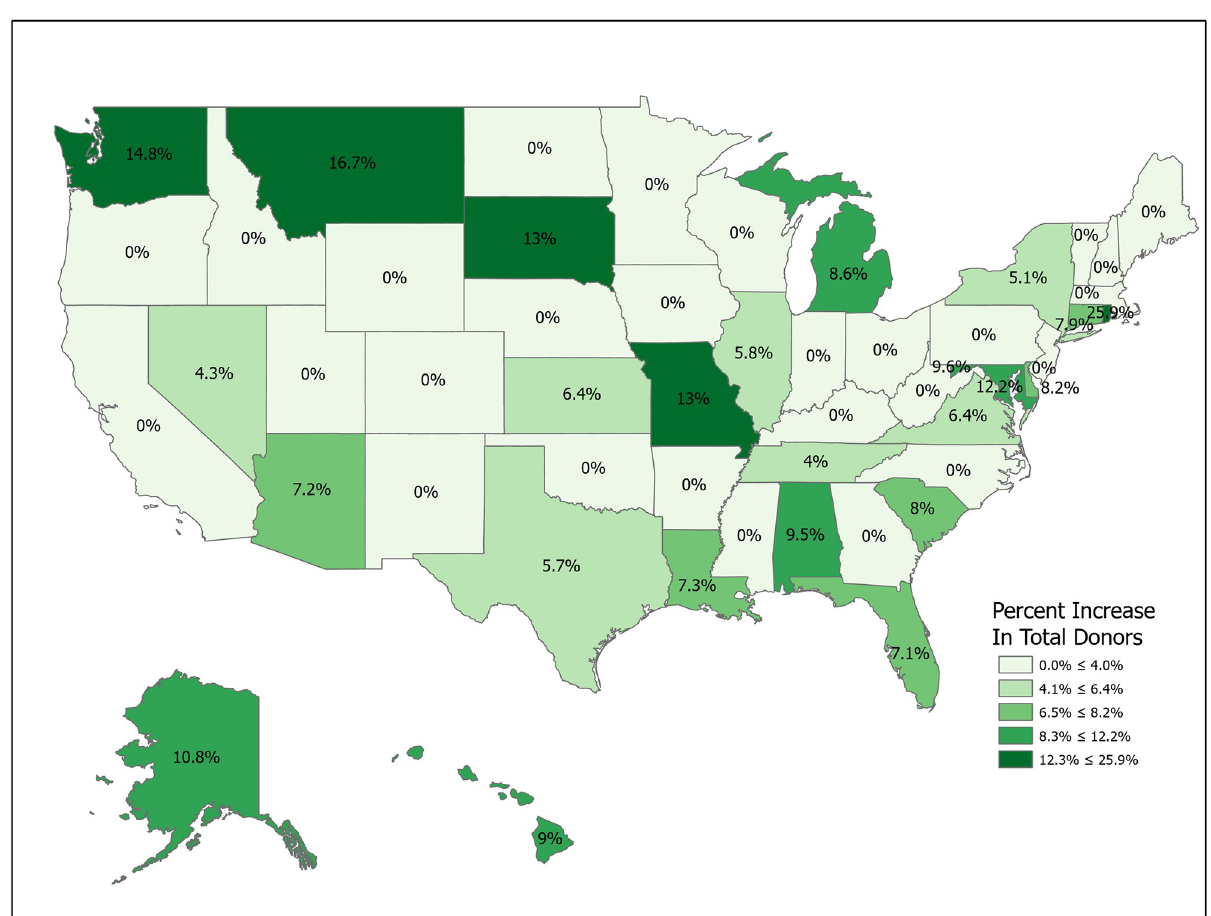
Fig 8. Simulation 2: Target high Δ states. Data come from Table 6. Maps created by ArcGIS Pro, URL: https://www.esri.com/en-us/arcgis/products/ arcgis-pro/overview. Base Map: World Light Gray Base, URL: https://services.arcgisonline.com/arcgis/rest/services/Canvas.